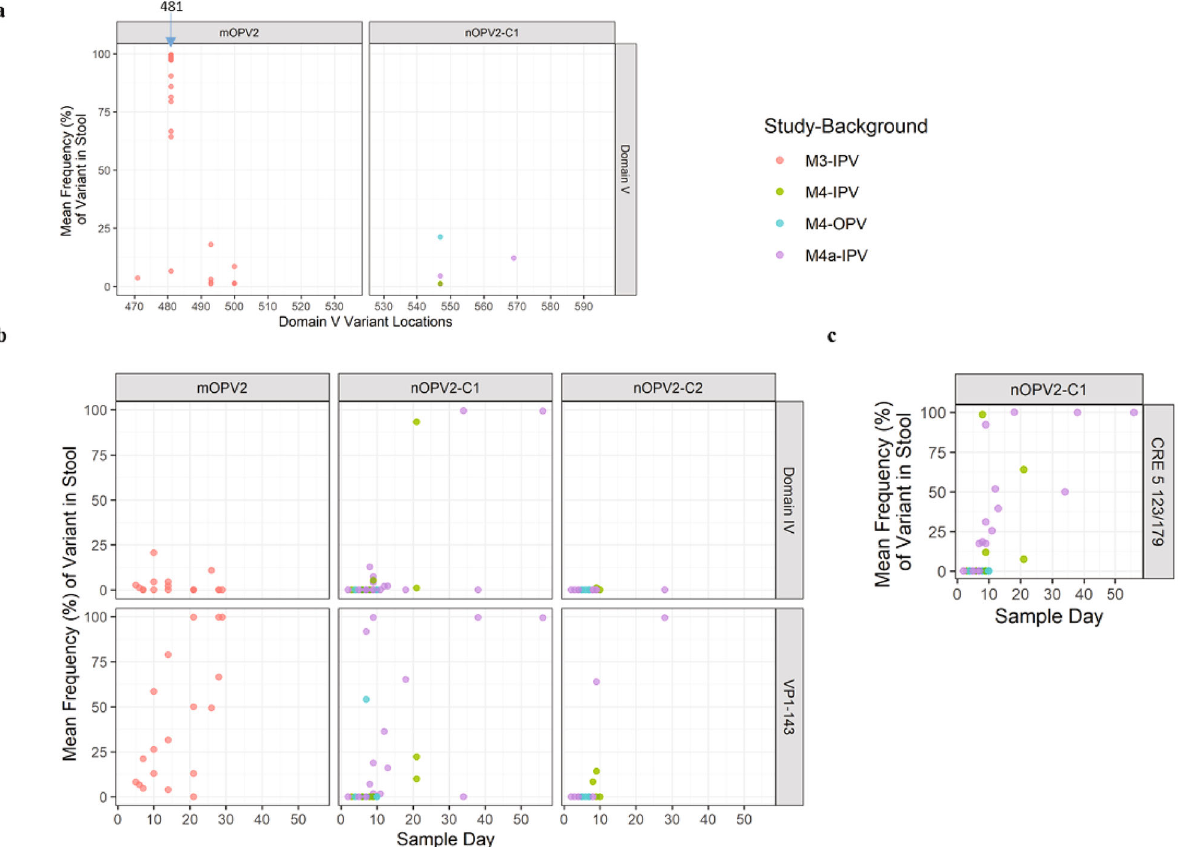
Fig. 7 Frequency of key variants in EES by position or as a function of day post-vaccine administration. Mean frequencies of variants from two stools (if present) for each EES from each trial M4a, M4 and M3 are plotted. If variant is only present in 1 stool that value is presented. If variant is not present in either, assigned 0 for plotting purposes in b and c . a Domain V polymorphisms (468-535 for mOPV2/529-596 for nOPV2-c1) at each nucleotide position. b Domain IV (398 for mOPV2 and nOPV2-c2/459 for nOPV2-c1) and VP1-143 polymorphisms (2908- 2910 for mOPV2 and nOPV2-c2/2969-2971 for nOPV2-c1) presented in aggregate as a function of EES day. c Cre5 123/179 in aggregate for nOPV-c1. All variants reported have Q scores ≥